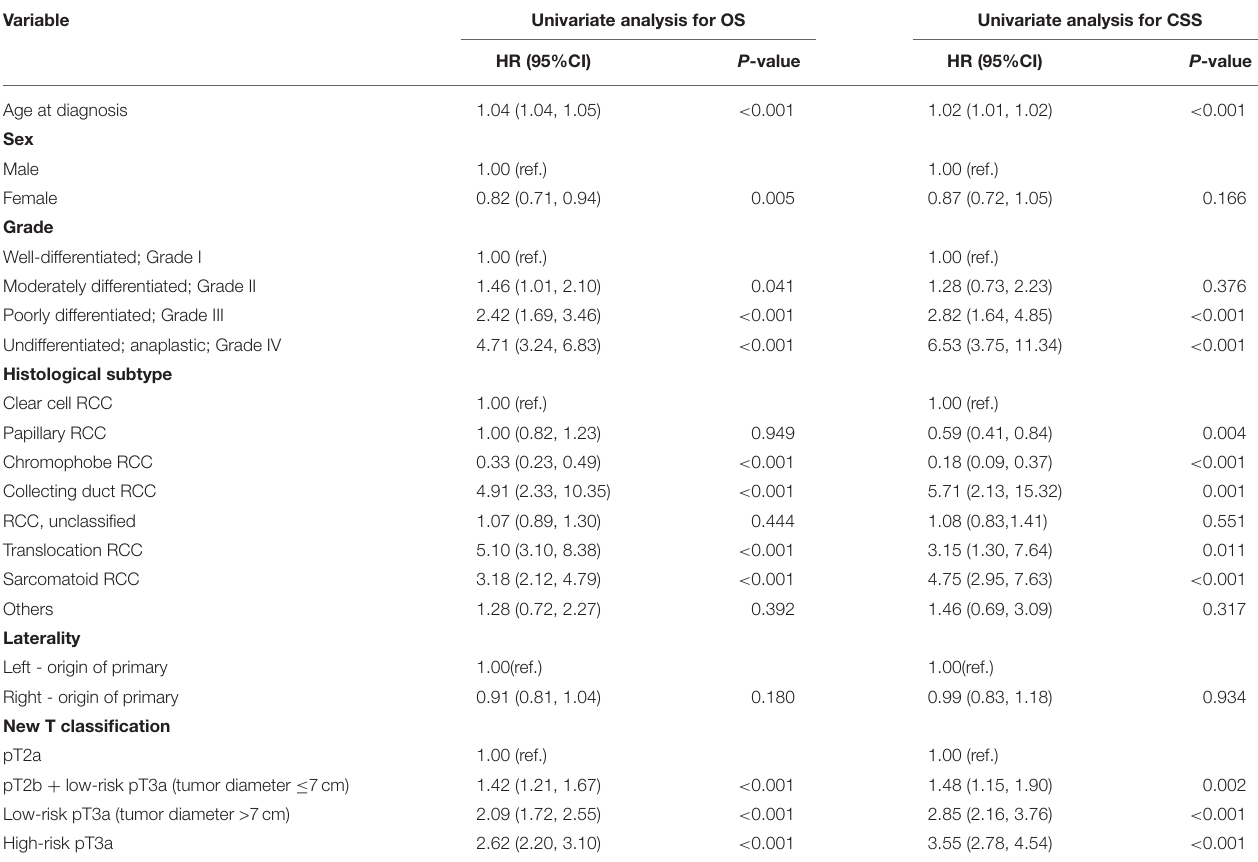
TABLE 2 | Univariate analyses for overall survival (OS) and cancer-specific survival (CSS). Variable